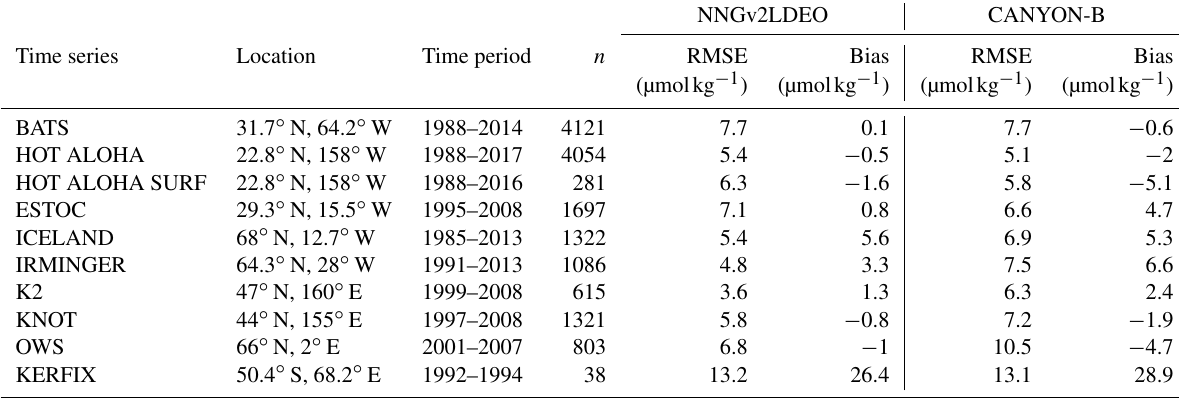
Table 3. RMSE and bias between measured and computed TCO 2 concentrations in several time series. The comparison was done using only water samples where all the input variables for NNGv2LDEO and the TCO 2 were measured in the same water sample. NNGv2LDEO